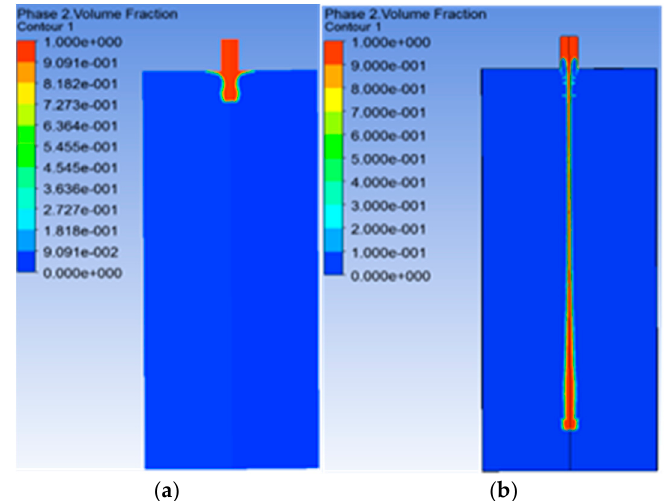
Figure 1. The numerical results of telopode elongation at t = 0 s ( a ) and t = 0.1027 s ( b ), obtained through the finite element method model using a viscoelastic constitutive law for the mathematical model [4]. The numerical model simulates the telopode elongation, the main feature of telocytes (TCs) behavior, and it presents the tracking of the interface between phase 0 (outside the telocyte, marked in blue) and phase 1 (the telocyte body marked in red) by the volume fraction entity.